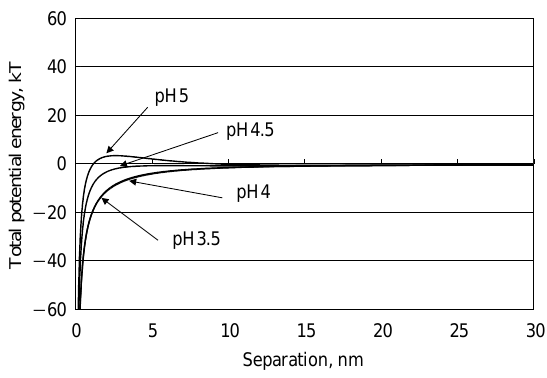
Total potential energy curves between 100nm silica and FS system as a function of separation distance. The curves from top to bottom are for pH5, 4.5, 4, 3.5, in that order.